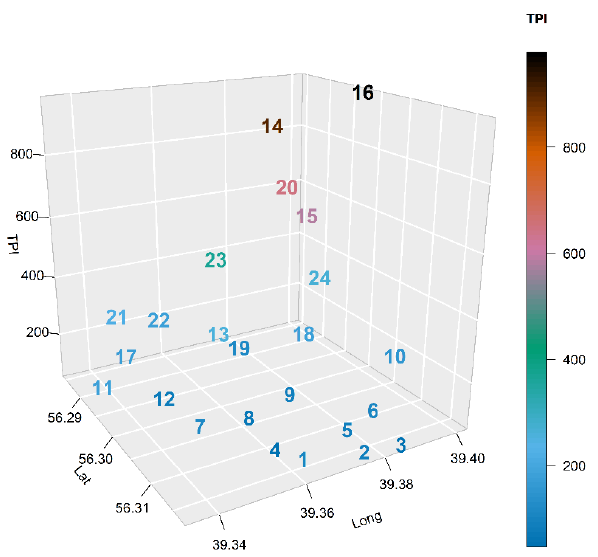
Figure 6. The distribution of the total pollution index (TPI).